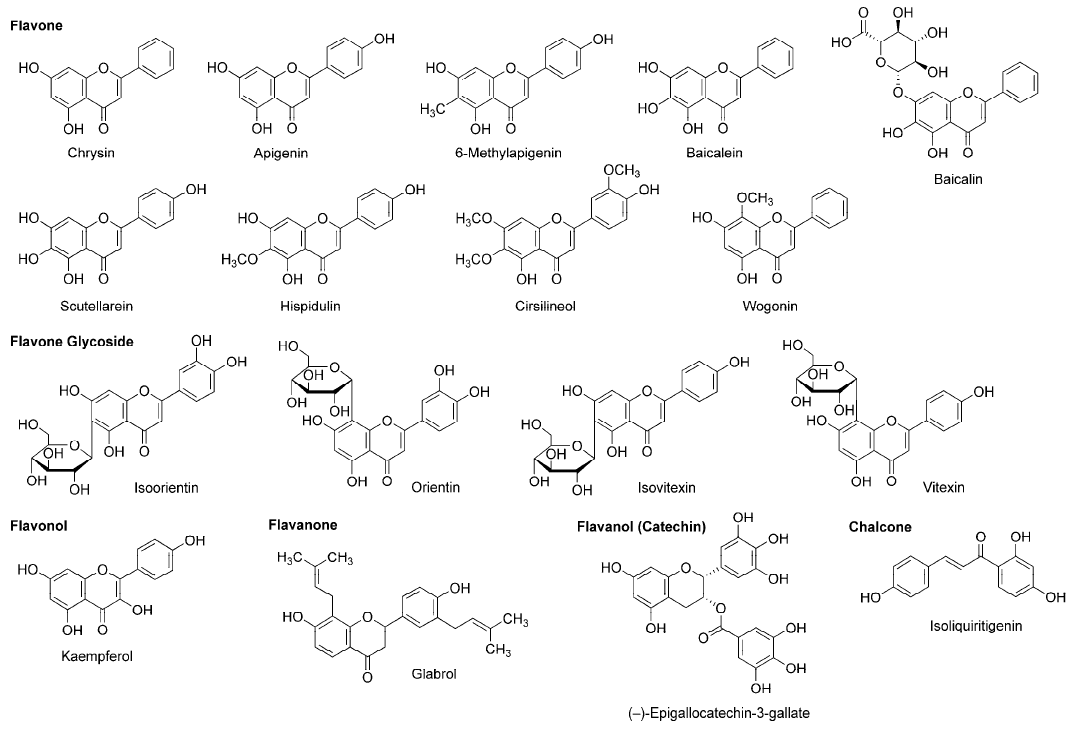
Figure 8. Flavonoids with the general anesthetic activity.